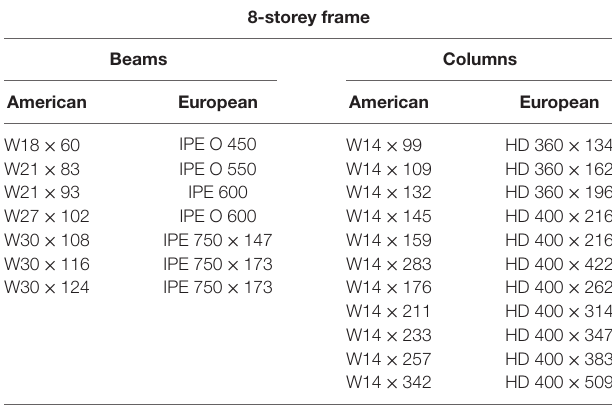
TaBle 3 | Selection of equivalent European sections for 8-storey frame.